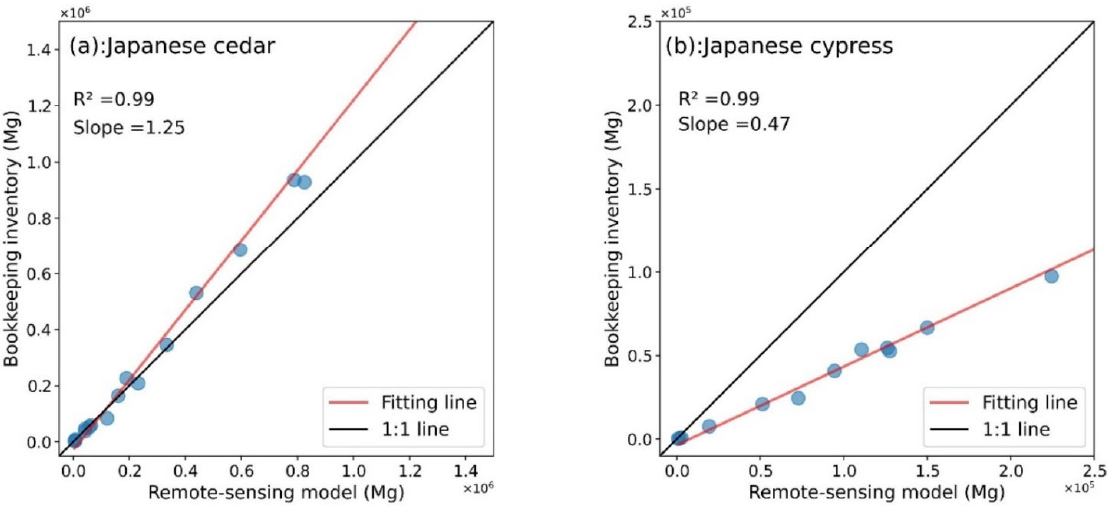
Figure 11. Comparison of total aboveground biomass (AGB) between statistical data in the Japanese forest register and the remote ‐ sensing data. Note that the scales differ greatly between the two species. Each data point represents the cumulative AGB at each of 17 targeted places (villages, towns, and cities) in Ibaraki